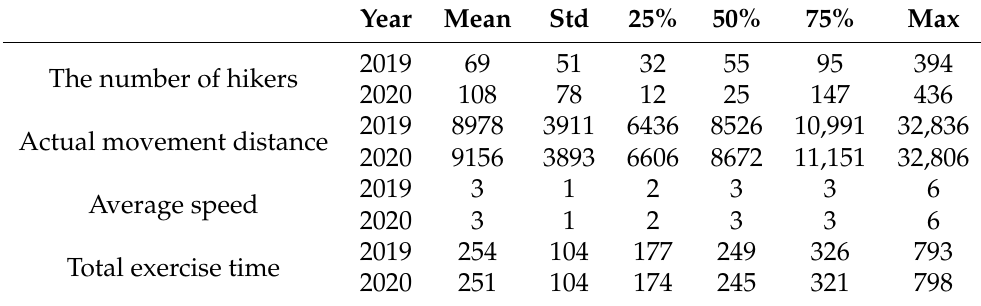
Table 1. Comparison of representation values for each